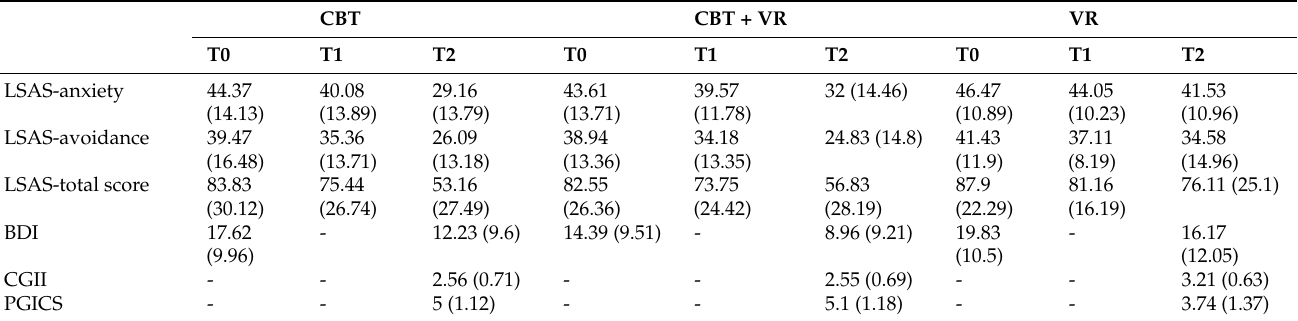
Table 5. Means and standard deviations for time of measurement of primary and secondary efficacy